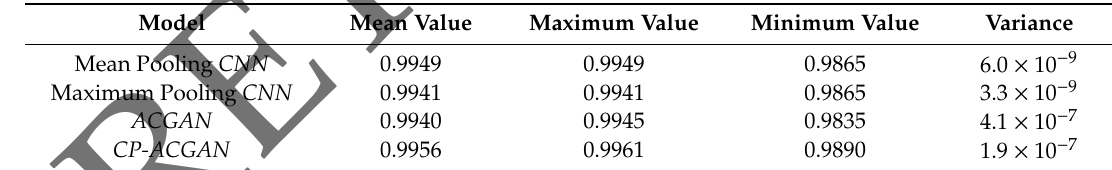
Table 2. MNIST prediction accuracy mean value, maximum value, minimum value and variance of different methods in 1,000 testing epochs.